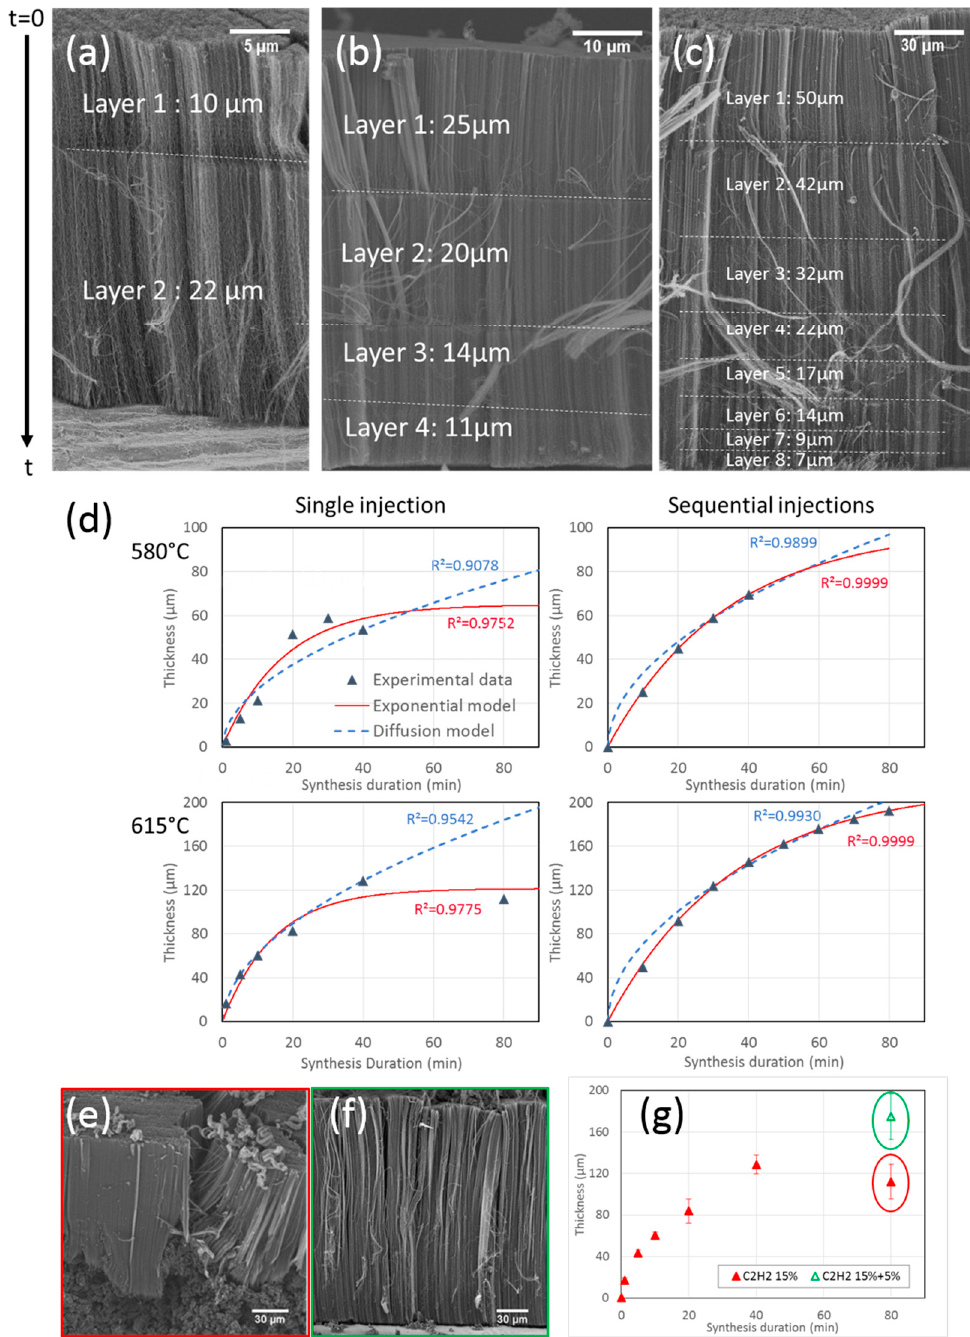
Figure 6. SEM images of carpets obtained with sequences of ( a ) 5 min then 10 min at 580 °C, ( b ) 4 × 10 min at 580 °C and ( c ) 8 × 10 min at 615 °C. ( d ) Fits of experimental data with exponential model (red) and diffusion model (blue). ( e , f ) SEM images of carpets obtained at 615 °C for 80 min without ( e ) or with ( f ) reduction of C 2 H 2 flow rate after 20 min. ( g ) Evolution of VACNT thickness with synthesis duration without (red) or with (green) reduction of C 2 H 2 flow rate after 20 min.